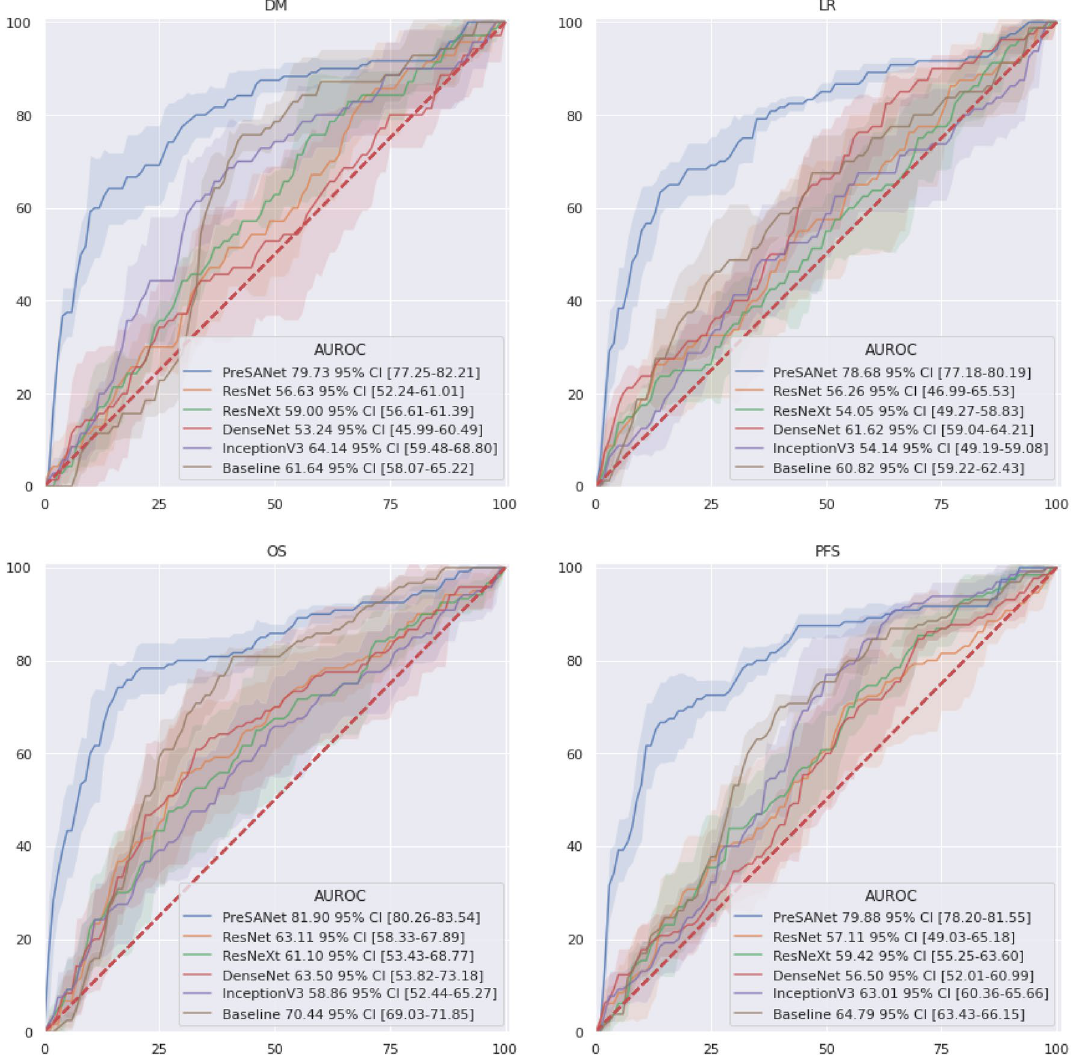
Figure 4. ROC curves for the proposed PreSANet model compared with previous works and off-the-shelf models. Figures presented are mean AUC [ 95% CI] over 5 trials. Training and validation split used is shown in Fig. 8A 30 . Figure created with seaborn/matplotlib v0.11.2